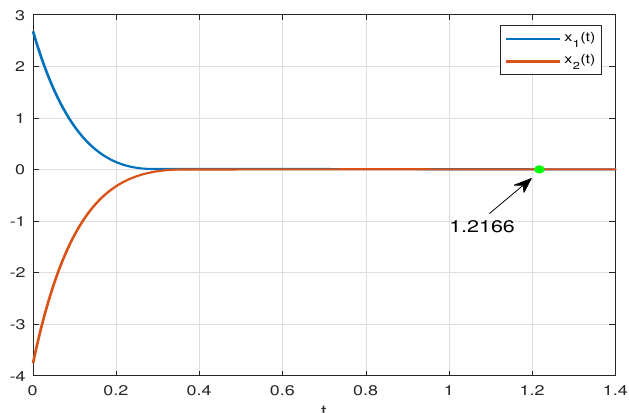
Figure 6. State behaviors of INNs (21) with delay-dependent reliable state-feedback control mecha- nism